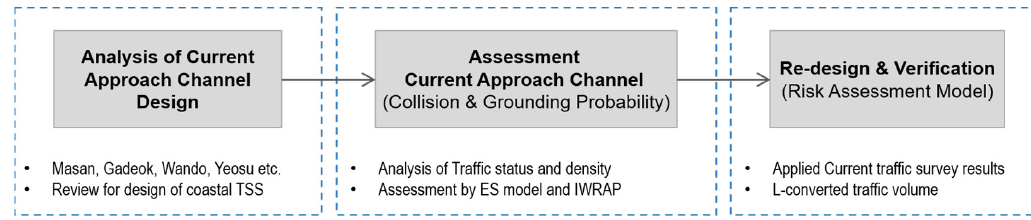
Figure 1. Flowchart of the study.